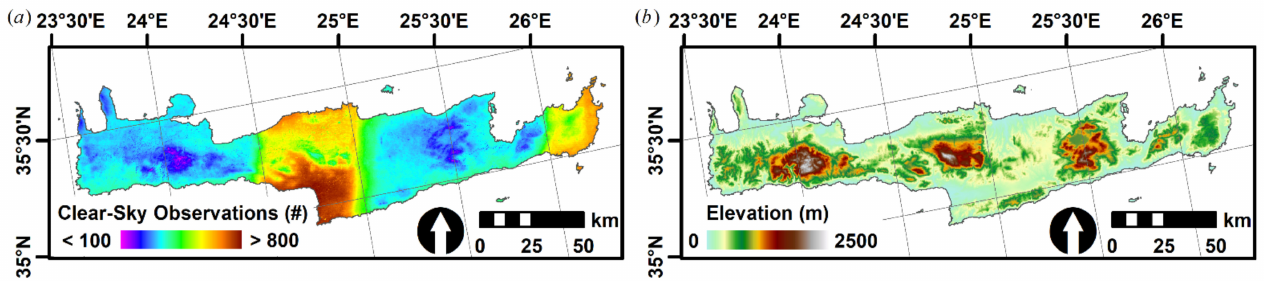
Figure 1. ( a ) Number of clear-sky Landsats 4–7 observations for 1984–2006 ( b ) and Digital Elevation